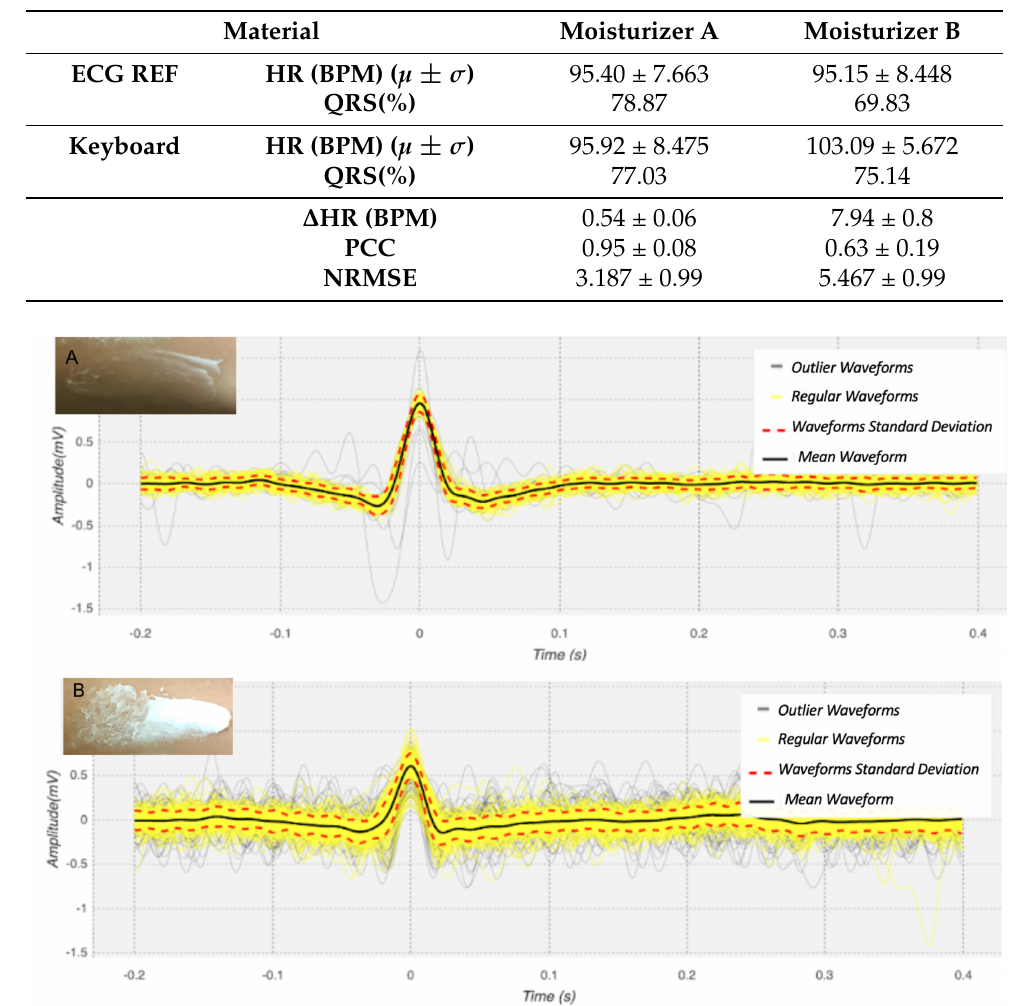
Table 5. Comparative analysis of the heart rate values for signals obtained with the electrode when low (A), and high (B) density skin moisturizers are applied to the skin.